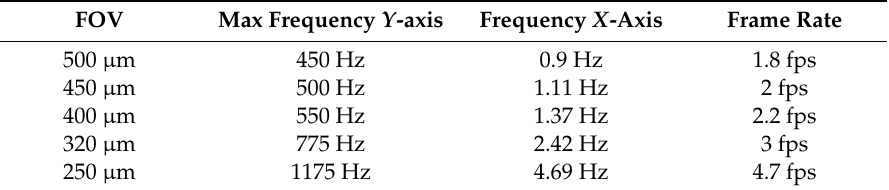
Table 2. The operating frequencies for both scanning axes for each imaging FOV with the maximum frame rate that can be reached for each